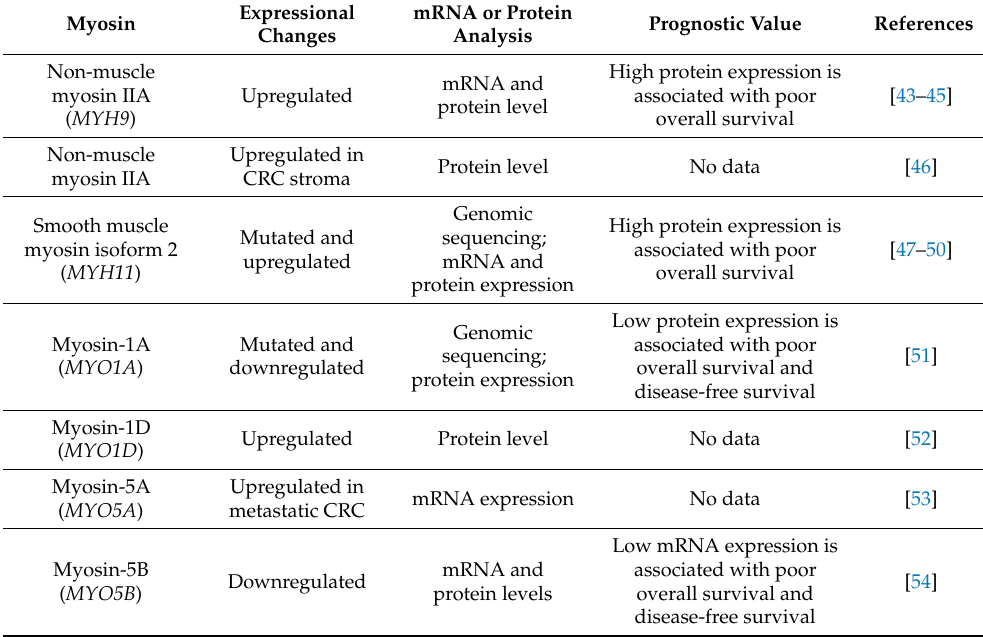
Table 1. Altered expression of different myosin motors in clinical colorectal cancer